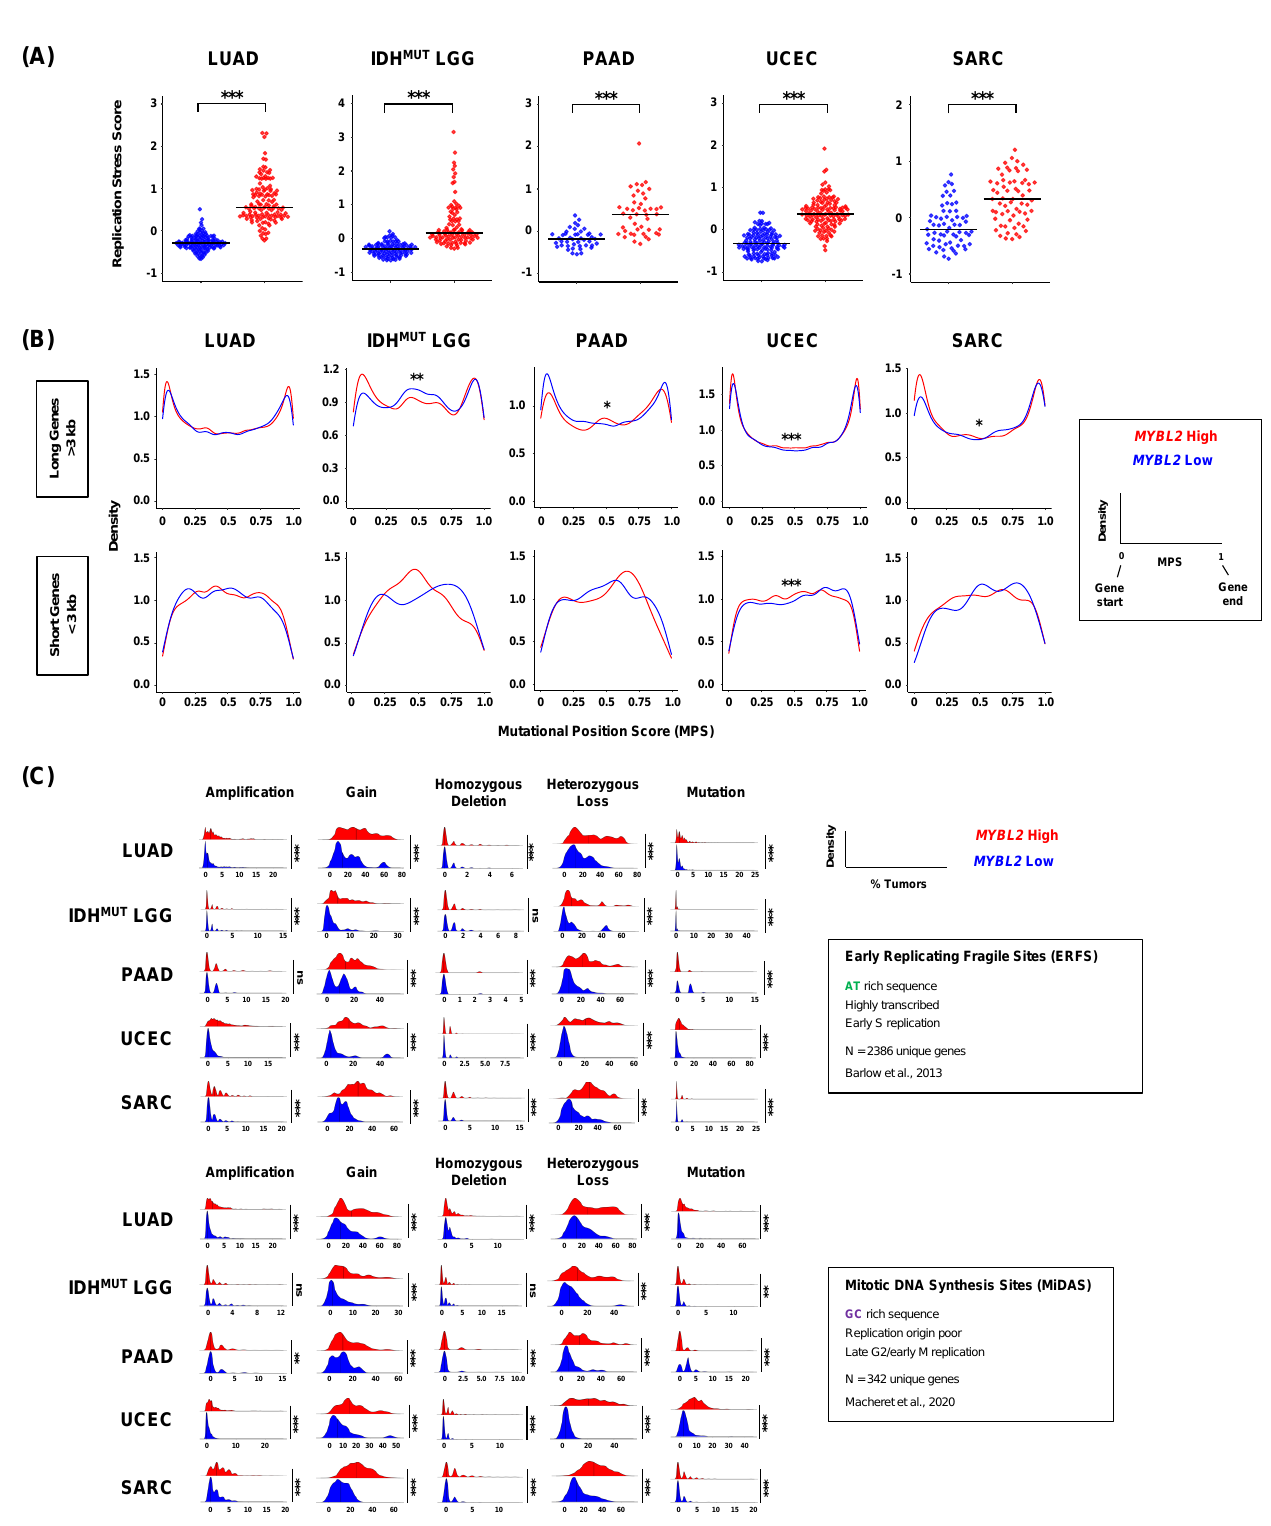
Figure 4. MYBL2 High tumors exhibit markers of chronic replication stress. ( A ) MYBL2 High tumors universally demonstrate significantly elevated replication stress scores. Wilcoxon, p < 0.001, ***. ( B ) MYBL2 High tumors experience a shift in intragenic somatic mutation position, relative to MYBL2 Low tumors. Kolmogorov-Smirnov test, p < 0.05, *; p < 0.01, **; p < 0.001, ***. ( C ) MYBL2 High tumors acquire significantly greater numbers of alterations at replication stress sensitive genomic sites. Wilcoxon, p < 0.01, **; p < 0.001, ***. ERFS sites [29], MiDAS sites